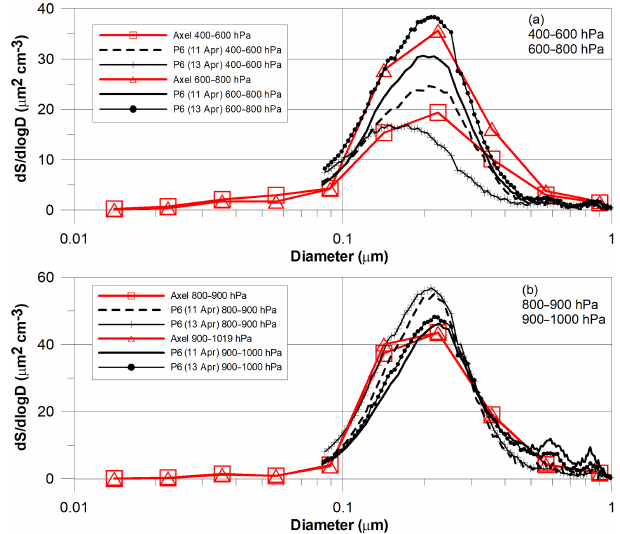
Figure 14. Comparison of modelled size distributions for the Axel grid and period of 1–14 April with the measured distributions from the Polar 6 (P6) flights on 11 and 13 April. All distributions are averaged for the indicated pressure intervals. (a) Modelled and measured distributions for pressure intervals of 400–600 and 600– 800hPa. (b) Modelled and measured distributions for pressure in- tervals of 800–900 and 900–1000hPa.